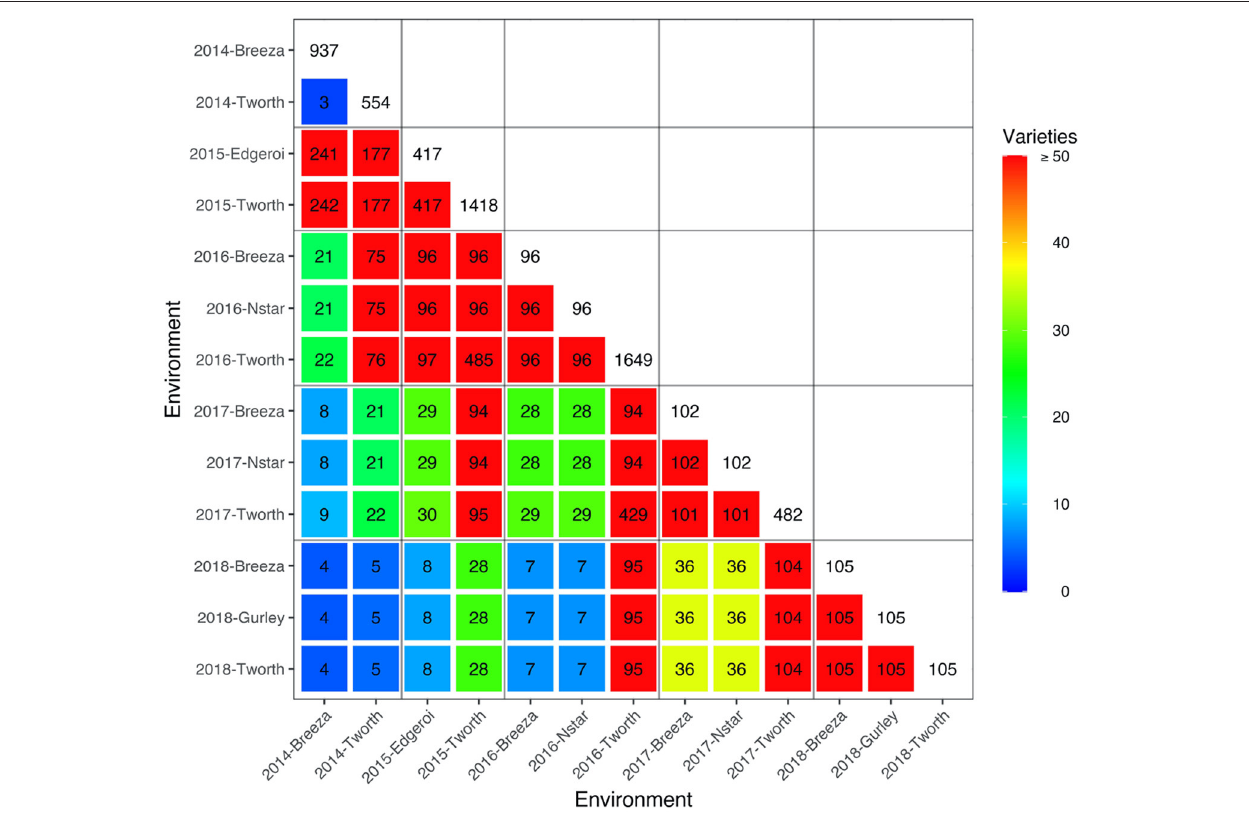
FIGURE 1 | Durum example: Heatmap of the number of varieties in common between all pairs of environments in the durum MET dataset. The colors as referenced in the legends. The boxes along the diagonal show the number of unique varieties in individual environments. Boundaries for years are indicated by the grey horizontal and vertical